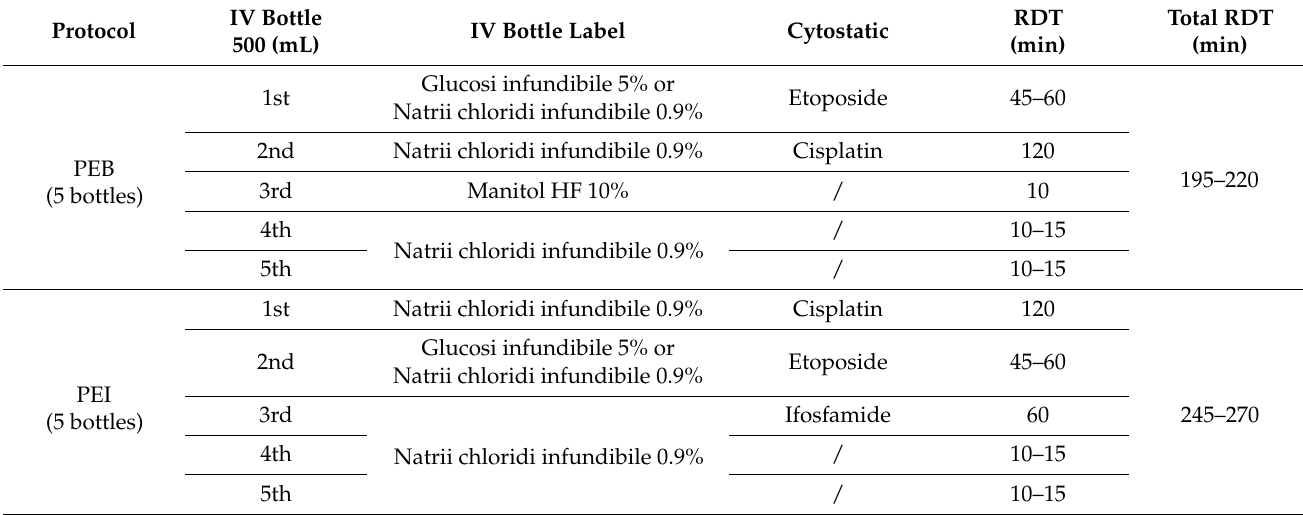
Table 1. Daily IV chemotherapy in the treatment of testicular cancer according to cisplatin/etoposide/bleomycin (PEB) and cisplatin/etoposide/ifosfamide (PEI) protocols: order of receiving IV bottles and recommended drip times (RDT) of infusion for each IV